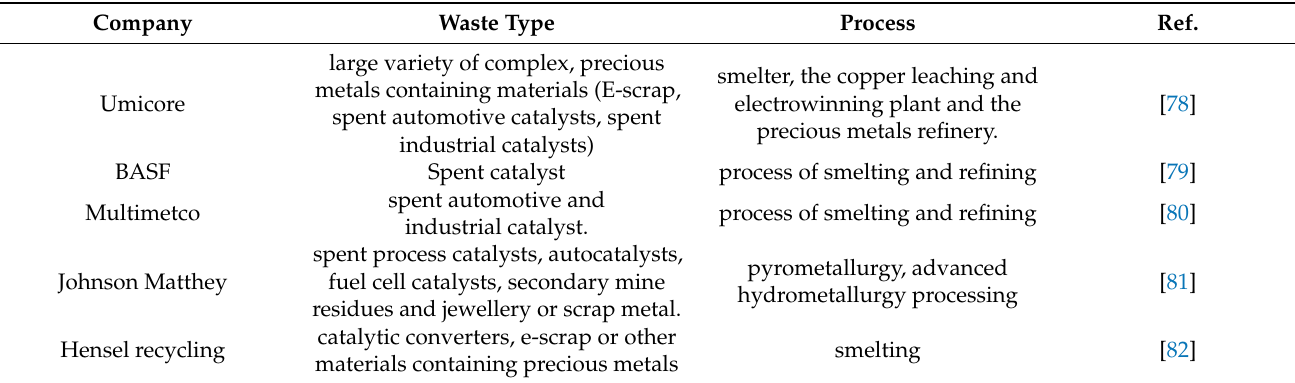
Table 3 lists some major PGM recycling companies in the world. Table 3. Companies involved in PGM